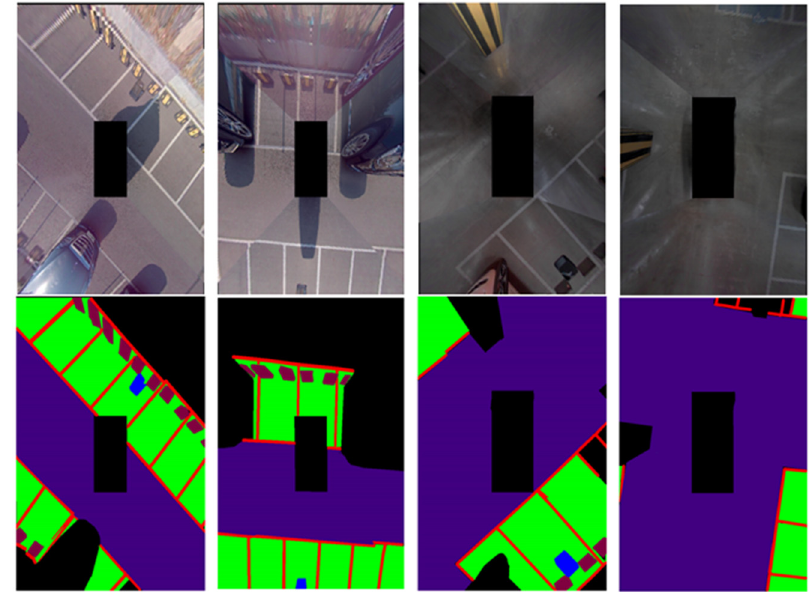
Figure 7. Example s of data labeling.